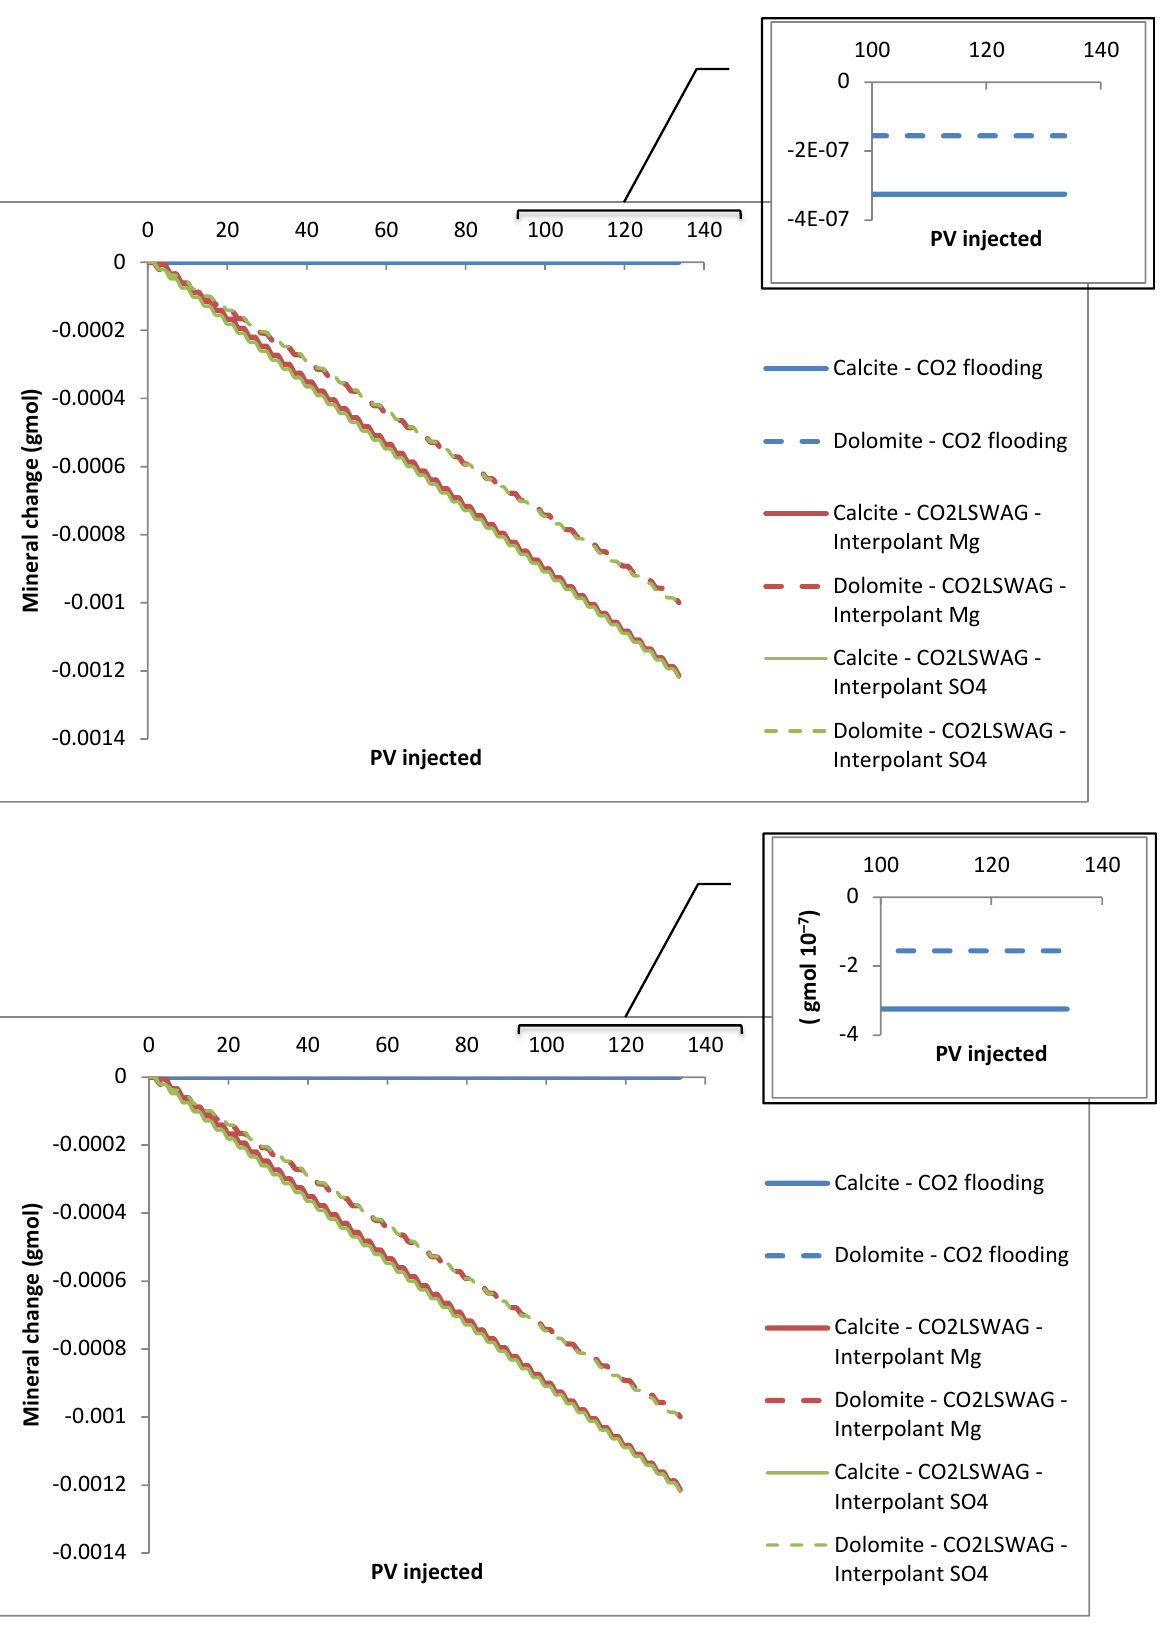
Figure 7. Mineral dissolution for continuous CO 2 injection and CO 2 -LSWAG considering Mg and SO 4 as ion interpolants.